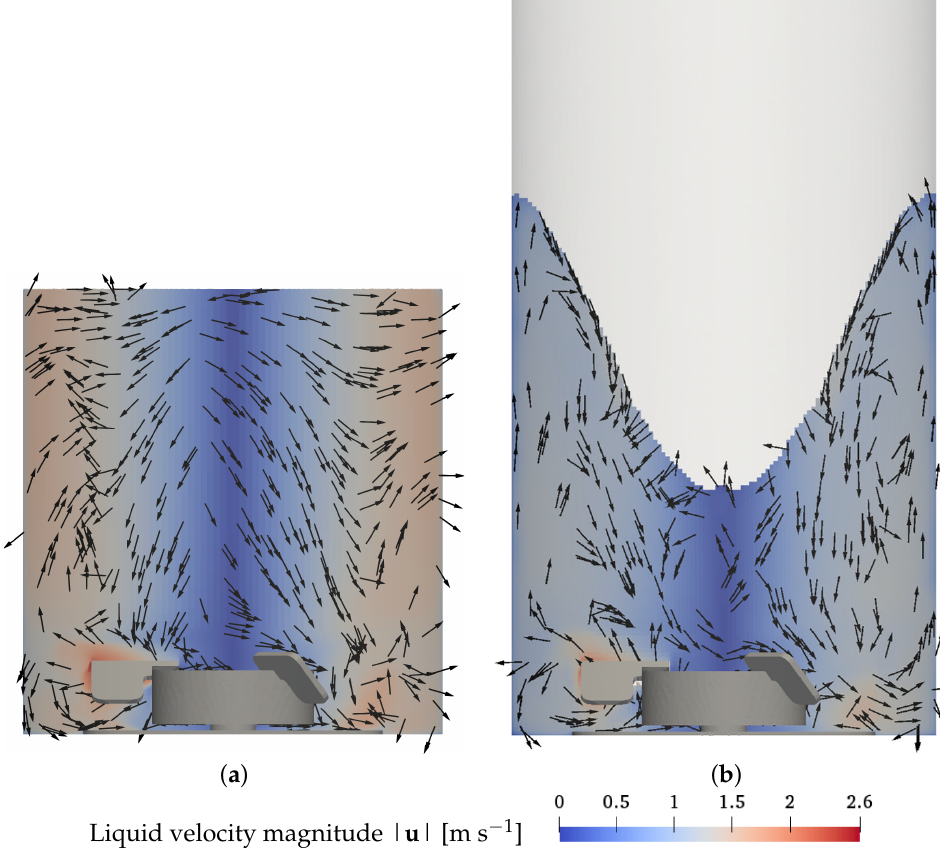
Figure 6. Liquid flow pattern for the maximum impeller speed condition (7 L, 360 rpm, 0.25 Lmin − 1 , 2 µ m) in the x - z plane through the center of the vessel. Arrows indicate the liquid velocity in x - z direction. ( a ) Euler–Lagrange results; ( b ) Euler–Euler